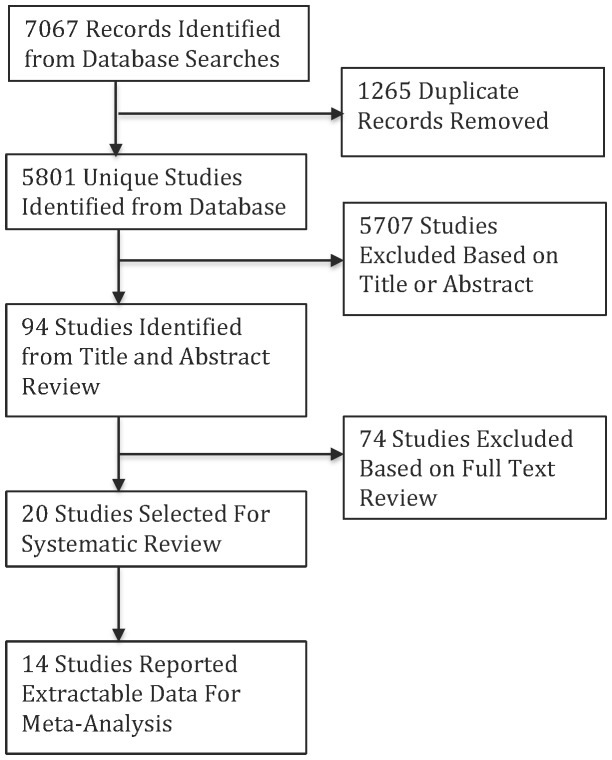
Systematic review flow chart.